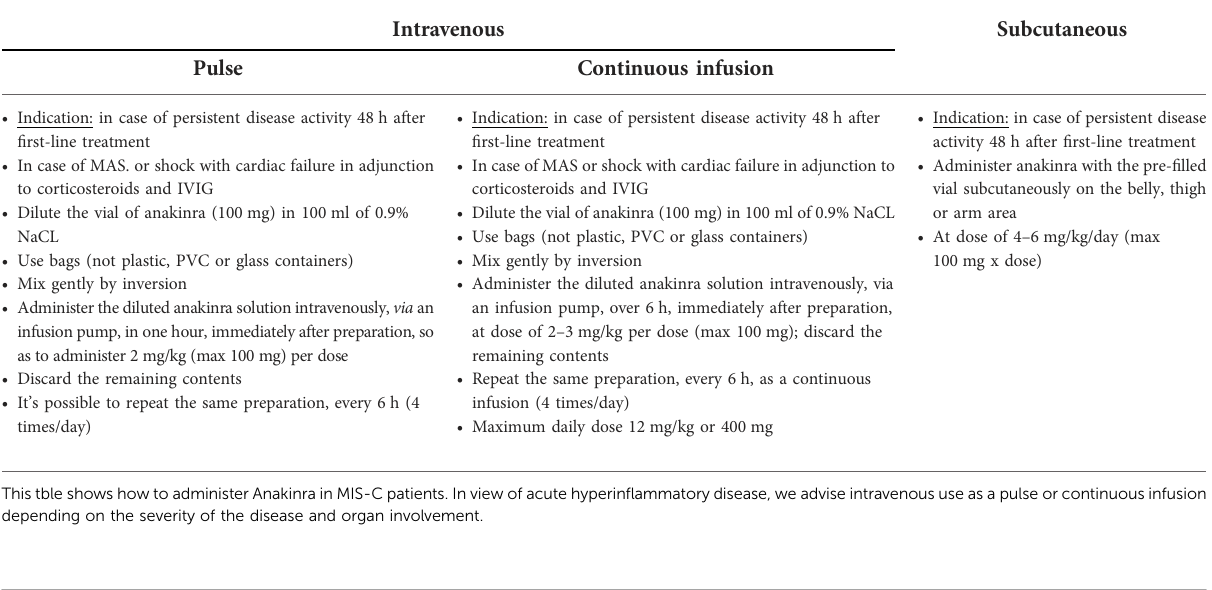
TABLE 2 Different modalities of Anakinra administration in MIS-C